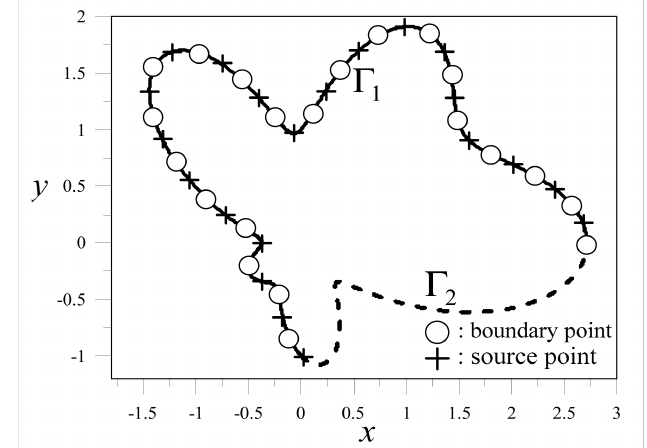
Figure 6. Illustration of the collocation points and boundary